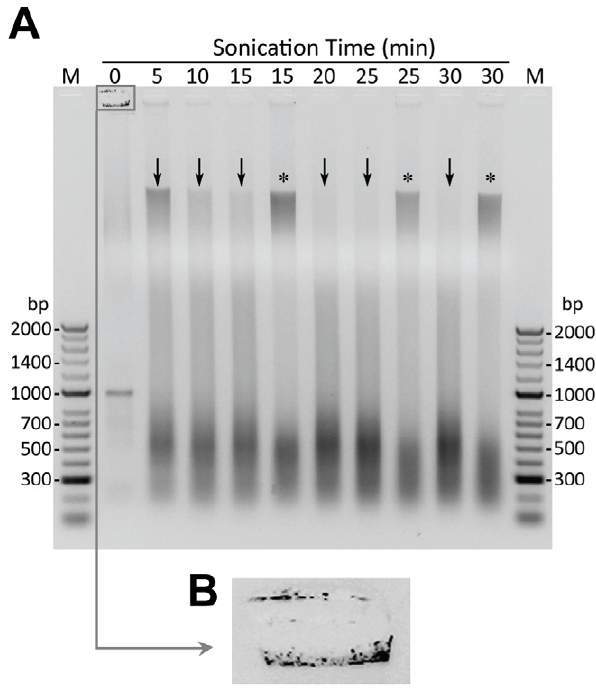
Figure 1. Effect of Sonication Time on Degree of Chromatin Shearing in Fresh or Frozen Cell Suspensions. Fixed rat SMC (10 7 cells/ml) were sonicated in 5 min intervals from 5 to 30 min then reverse cross-linking was performed before DNA was extracted using PCIA. Final DNA concentrations were determined via nanospectropho- tometry; 2 m g of DNA per time point was used to evaluate the effect of shearing by electrophoresis in a 1% agarose gel ( A ). A small volume (7.5 m l) of unsonicated, unextracted sample (0 min) was also electro- phoresed for comparison ( M : a 100 base-pair DNA marker). Sonication was either performed immediately ( Q ) or performed after the samples had been frozen at –80 u C for two weeks ( * ). For fresh samples, increased sonication time decreased the amount of high molecular weight DNA and increased the amount of DNA accumulating in the 400 – 600 base pair region. In contrast, when samples were frozen then sonicated, a high molecular weight fraction of DNA persisted through 30 min indicating that freezing the sample altered the DNA’s susceptibility to shearing by sonication. Magnification of the well containing the ‘0 min’ sample component that failed to migrate into the gel ( B ) shows a punctuate pattern on both the positive and negative side of the well suggesting genomic DNA was retained in intact nuclei.